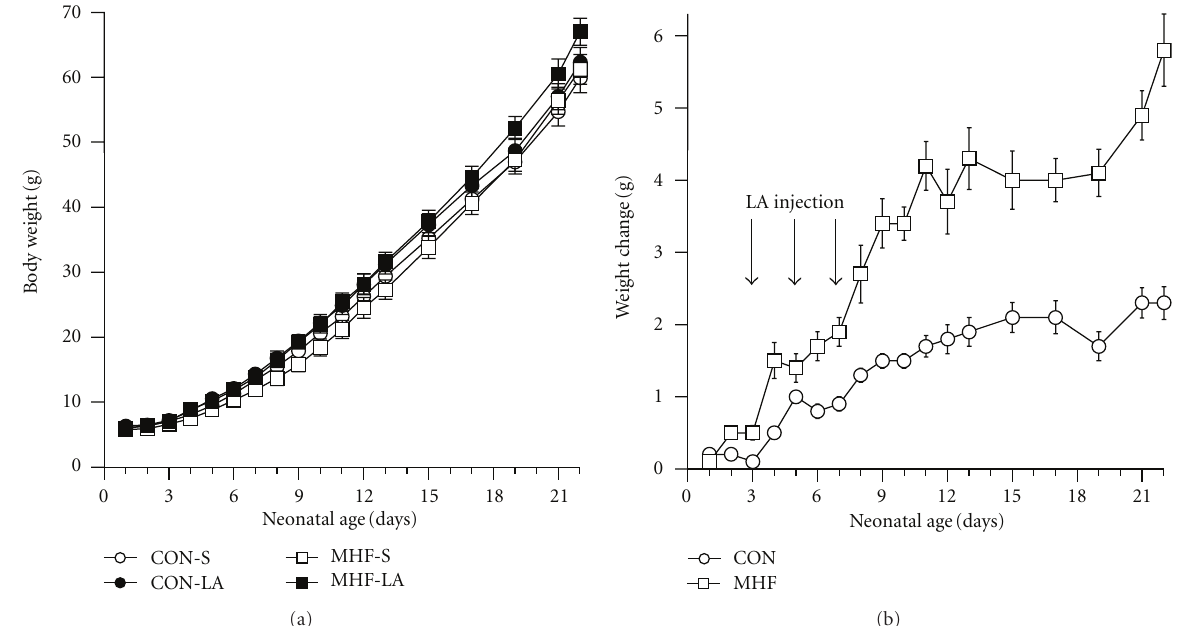
Figure 3: (a) Absolute body weights in male o ff spring from birth until weaning and (b) changes in neonatal body weights (grams, shown as delta di ff erence in body weight between LA and Sal treated o ff spring, Δ LA-Sal) in CON and MHF neonates from birth until the time of weaning (day 22). Arrows indicate time of injection with LA at neonatal days 3, 5, and 7. P < 0 . 005 for e ff ect of LA treatment; maternal diet × LA treatment interaction P < 0 . 05. N = minimum 16 per